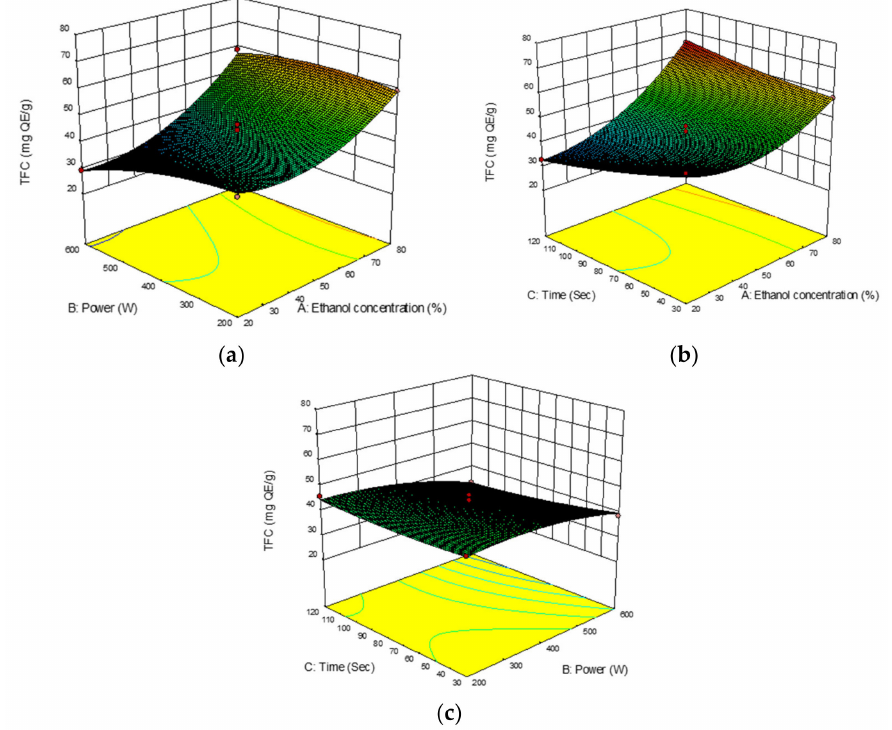
Figure 3. Response surface analysis (3D) of Barleria lupulina Lindl. leaf extract (BLLE) on total flavonoid content (TFC): ( a ) effect of ethanol concentration and microwave power; ( b ) effect of ethanol concentrations and extraction time; ( c ) effect of microwave power and extraction